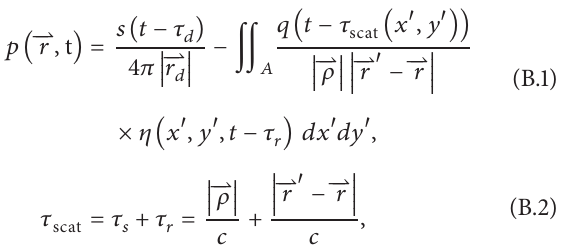
Figure 10: A sketch showing the coordinates of the source 𝑆 , the receiver 𝑅 , and the running scattering point [𝑥 󸀠 ,𝑦 󸀠 , 𝑓(𝑥 󸀠 , 𝑦 󸀠 )] on the sea surface 𝑓(𝑥,𝑦)